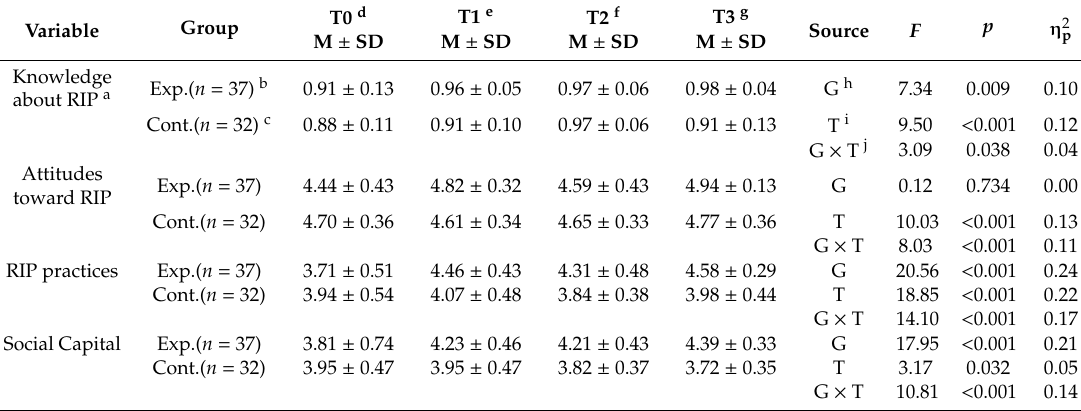
Table 4. Descriptive statistics for dependent variables and results of mixed ANOVA analyses ( N = 69).